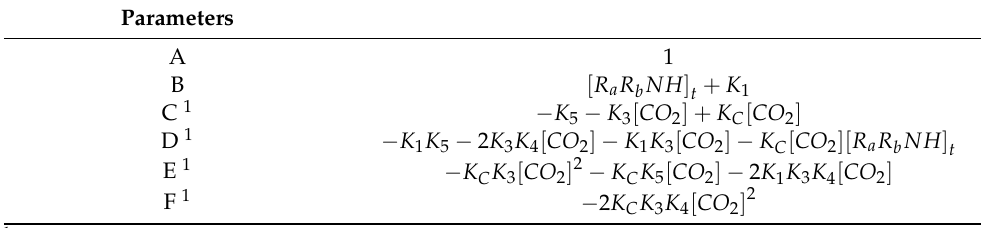
Table 4. Parameters of Equation (31).